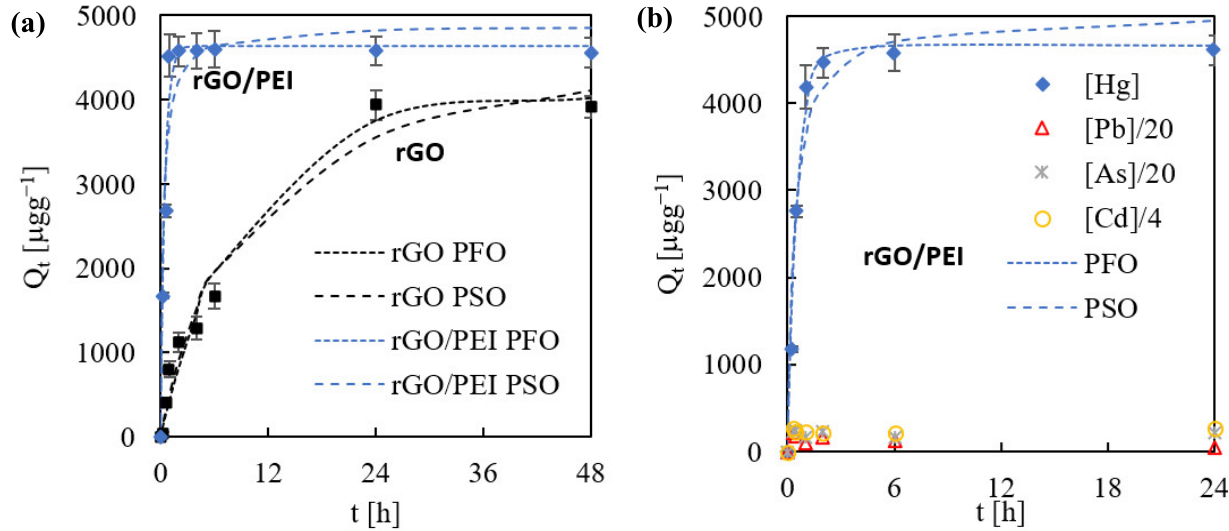
Figure 2. The experimental kinetic data points concerning the sorption of Hg(II) onto rGO/PEI over time and the fittings (dotted lines) of the PFO and PSO models for: ( a ) single metal, and ( b ) multicomponent solutions. Table 2. The maximum removal percentage (R E ) *, the contact time (c.t.) the sorbate–sorbent needed to reach equilibrium, and the PFO ** kinetic parameters (k 1 and C e ± standard deviations) obtained for the different sorbents regarding Hg(II) sorption in either a single or multicomponent solution. Sample Single Metal Multicomponent R E (wt%)